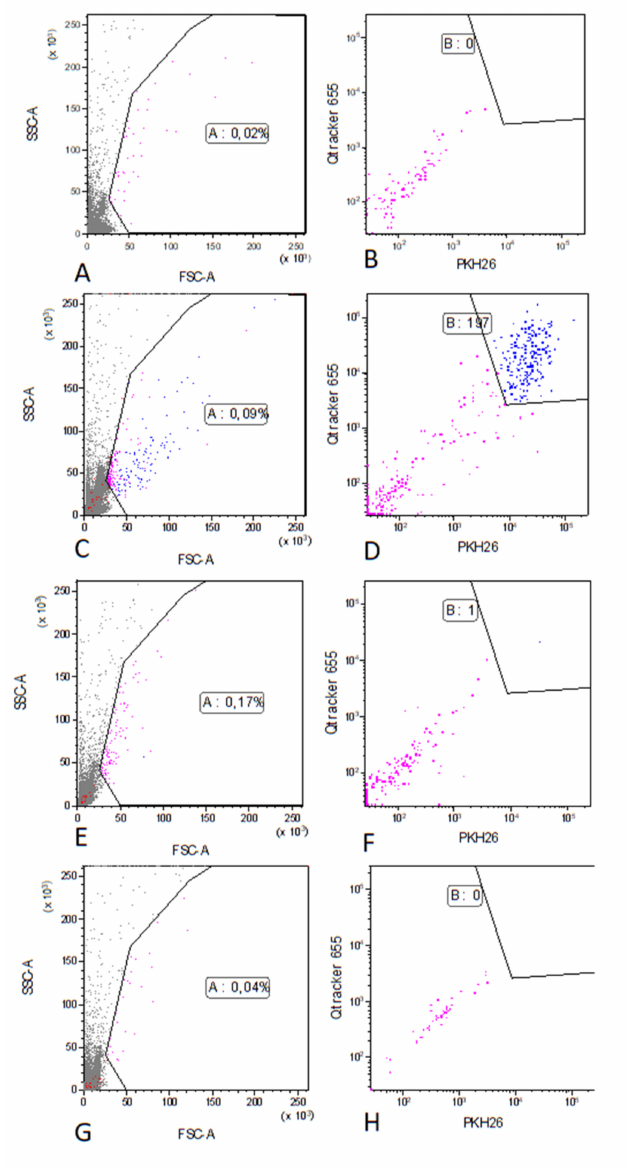
Figure A3. Example of flow cytometry results of reservoir samples. Results shown in forward and side scatter cytograms and fluorescence signal strength cytograms of Qtracker655 and PKH26. ( A ) T = 0 sample moment, FSC-A, SSC-A cytogram, purple dots represent cells that fall within the MSC gating; 0.02% of all cells. ( B ) PKH26 and Qtracker655 cytogram of t = 0 sample, purple dots represent particles that fall in the auto fluorescence range. No dots visible in the MSC range gate. ( C ) T = 60 sample moment, FSC-A, SSC-A cytogram, purple dots represent cells that fall within the MSC gating; 0.09% of all cells. ( D ) PKH26 and Qtracker655 cytogram of t = 60 sample moment, purple dots represent particles that fall in the auto fluorescence range, blue dots represent cells that fall within the MSC range gate; 0.22%. ( E ) T = 240 sample moment, FSC-A, SSC-A cytogram, purple dots represent cells that fall within the MSC gating; 0.17% of all the cells. ( F ) PKH26 and Qtracker655 cytogram of t = 240 sample moment, purple dots represent particles that fall in the auto fluorescence range, blue dot represents a cell that falls within the MSC range gate; 0.06%. ( G ) T = 420 sample moment, FSC-A, SSC-A cytogram, purple dots represent cells that fall within the MSC gating; 0.04% of all counted cells. ( H ) PKH26 and Qtracker655 cytogram of T = 420 sample moment, purple dots represent particles that fall in the auto fluorescence range, no dots visible in the MSC range